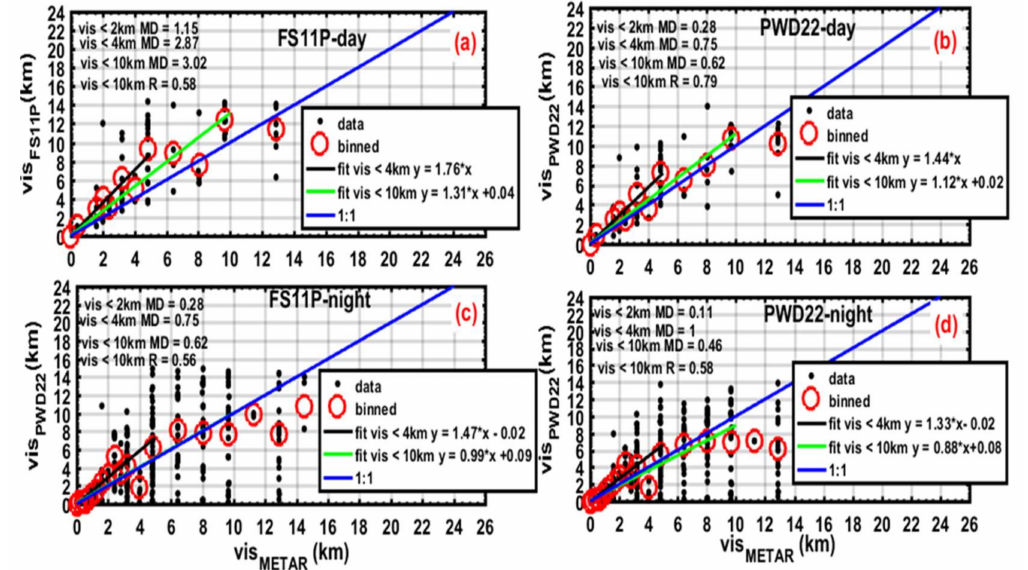
Figure 8. The measured visibility using the Vaisala FS11P (day ( a ) and night ( c )) and PWD22 (day ( b ) and night ( d )) plotted against human observer data (VIS METAR ).